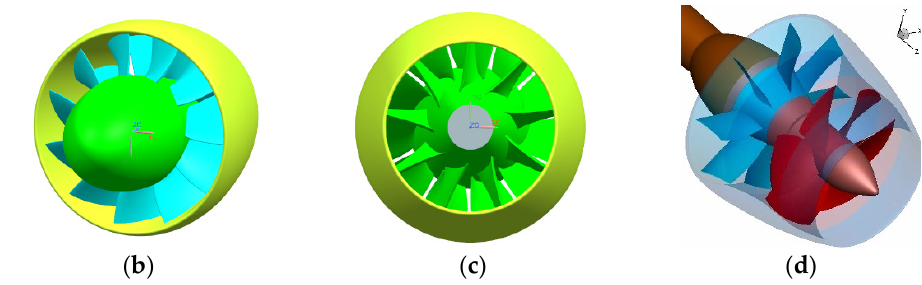
Figure 1. Geometric model of PJP. ( a ) Pre-swirl rotor; ( b ) Rotor blades; ( c ) Stator blades; ( d ) Pre- swirl stator. Table 1. Model parameters of PJP.